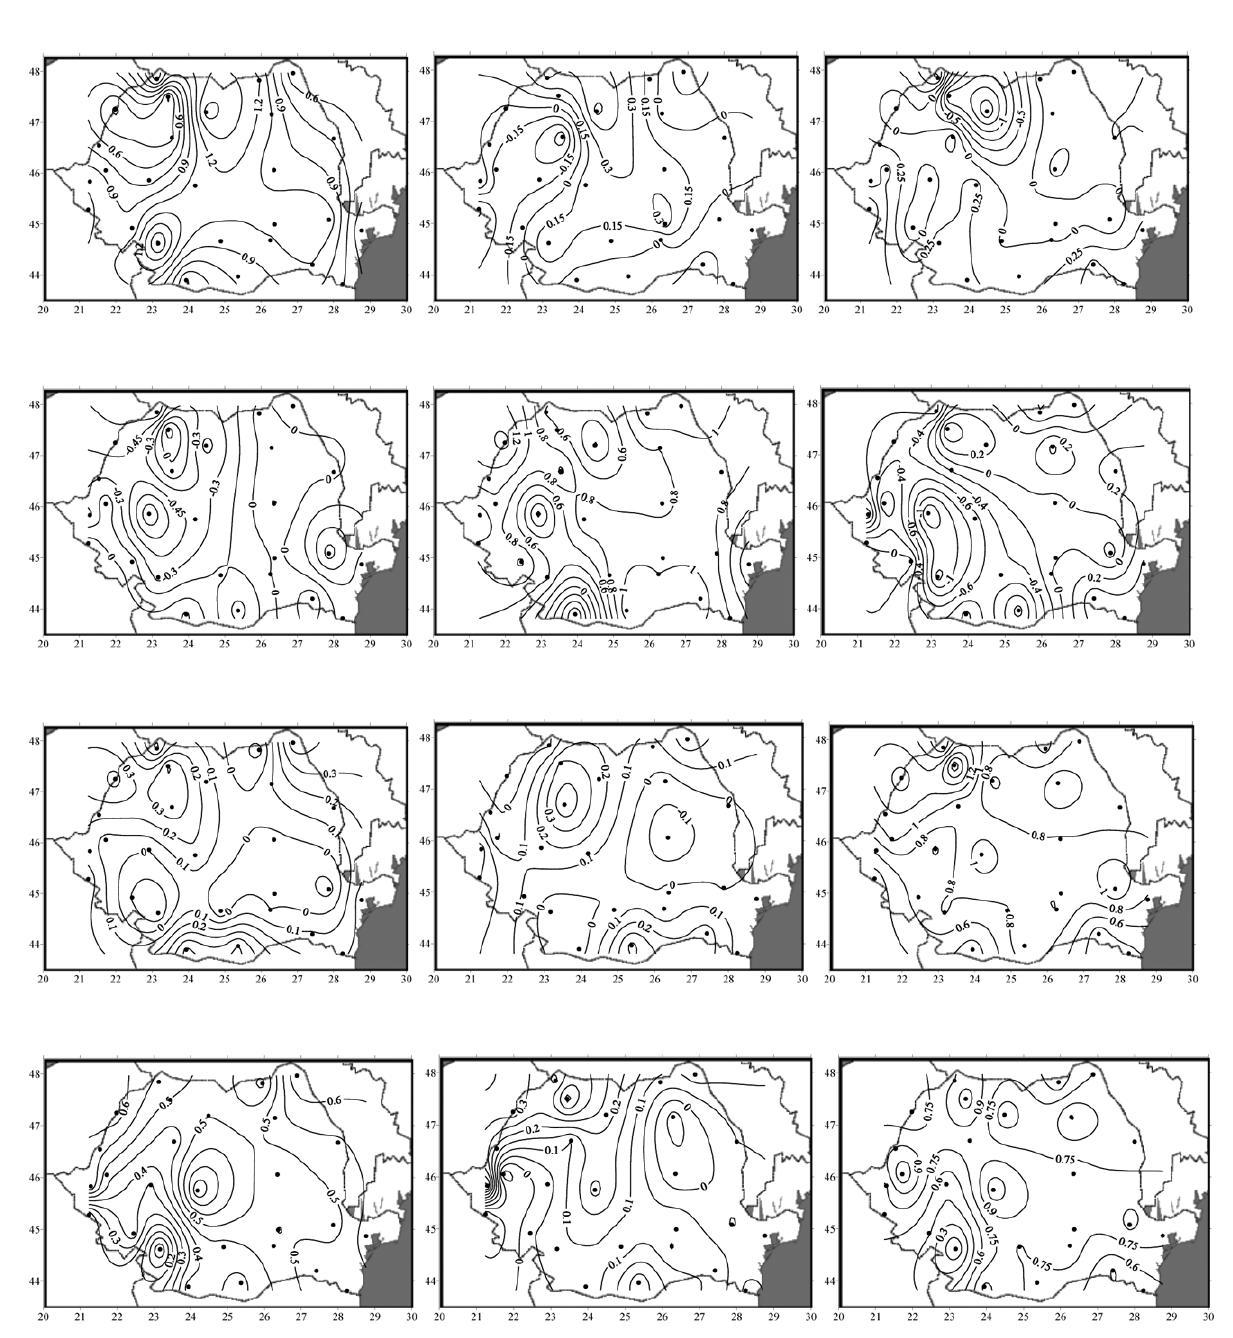
, a , a ; b , b , b ; c , c , c ; g , g , g x y z x y z x y z x y z